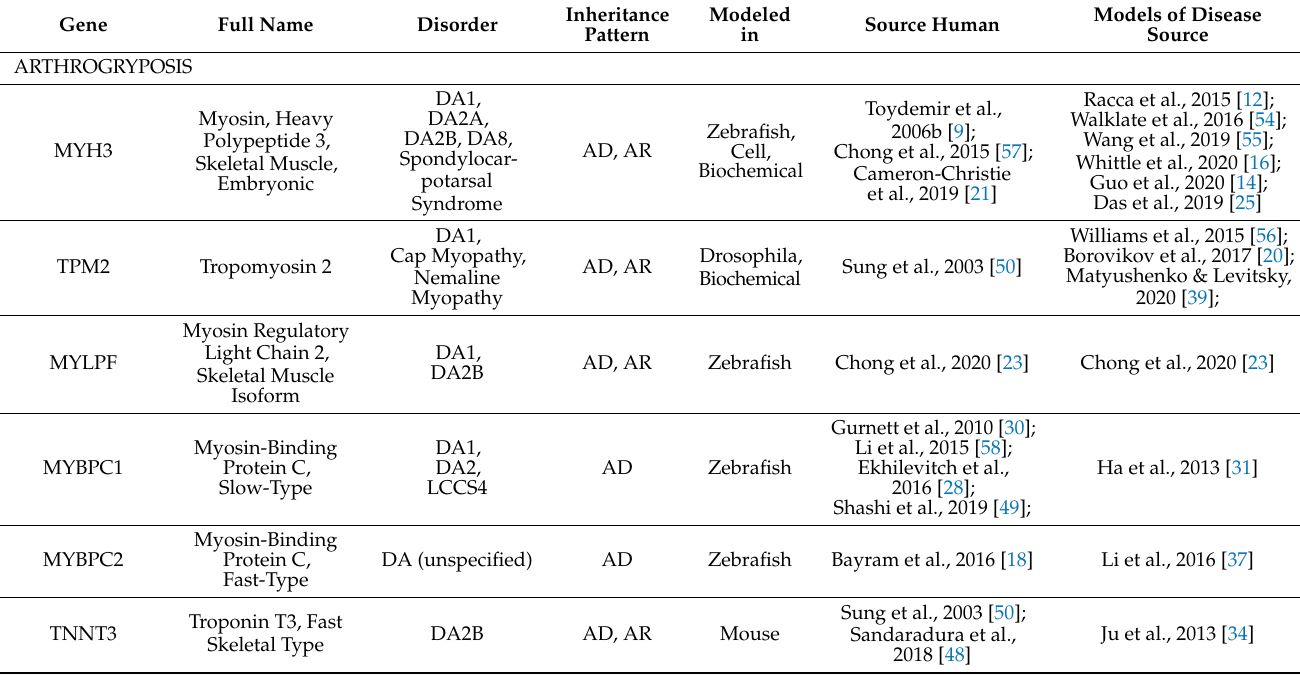
Table 1. List of genes and associated conditions and models of distal arthrogryposis (DA) and lethal congenital contracture syndrome (LCCS) used for study. Autosomal dominant (AD), Autosomal recessive (AR) [9,11,12,14,16–57].